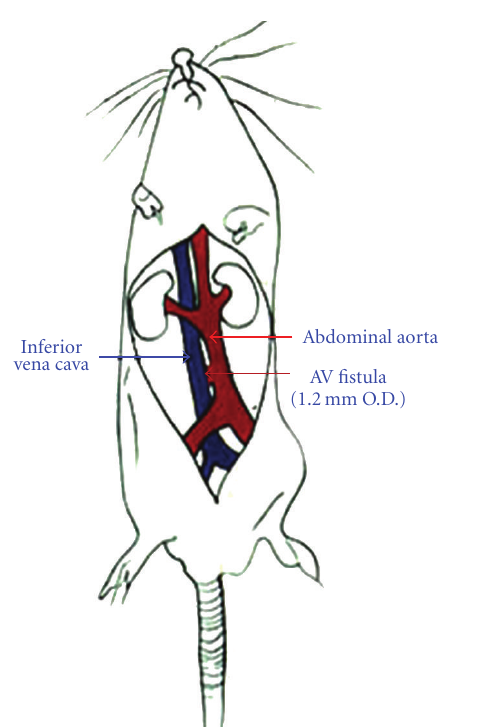
Figure 1: A schematic description of the creation of aortocaval fistula (ACF) in rats, an experimental model of volume-overload CHF.